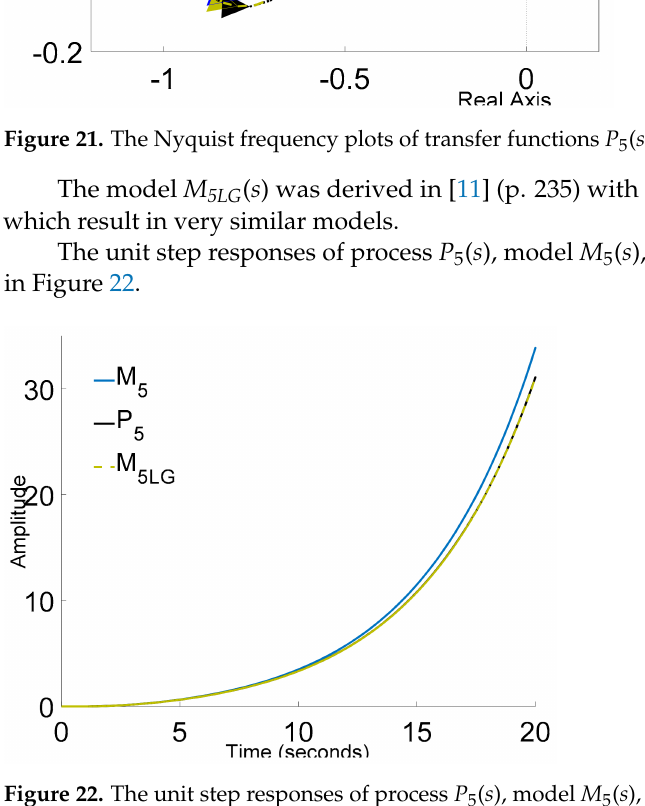
Figure 22. The unit step responses of process P 5 ( s ), model M 5 ( s ), and model M 5 LG ( s